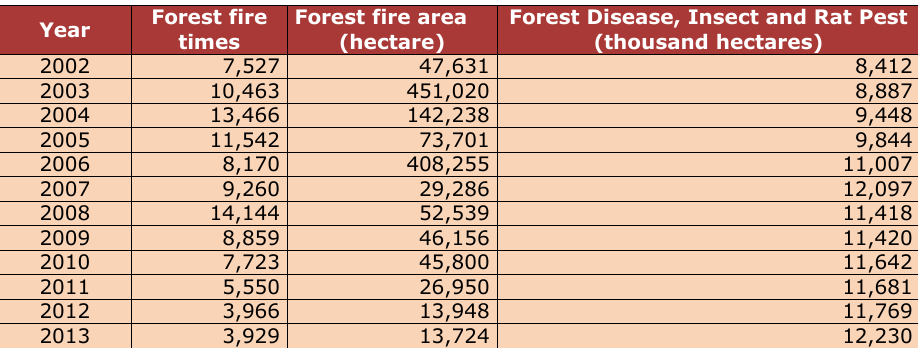
Table 1. Forest disaster situation in China from 2002 to